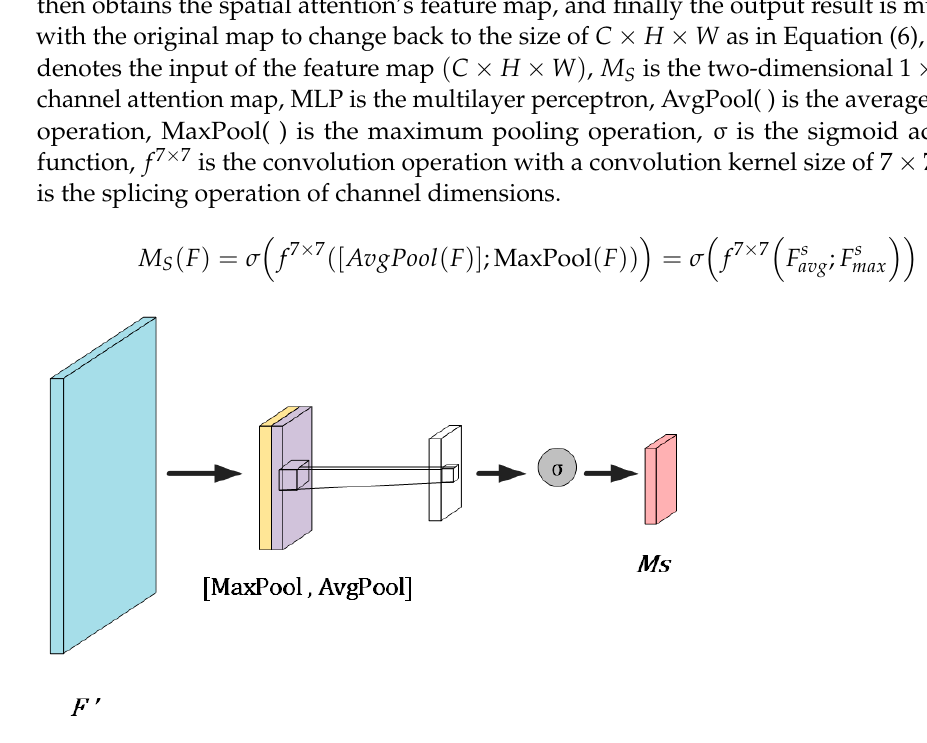
Figure 6. Spatial attention